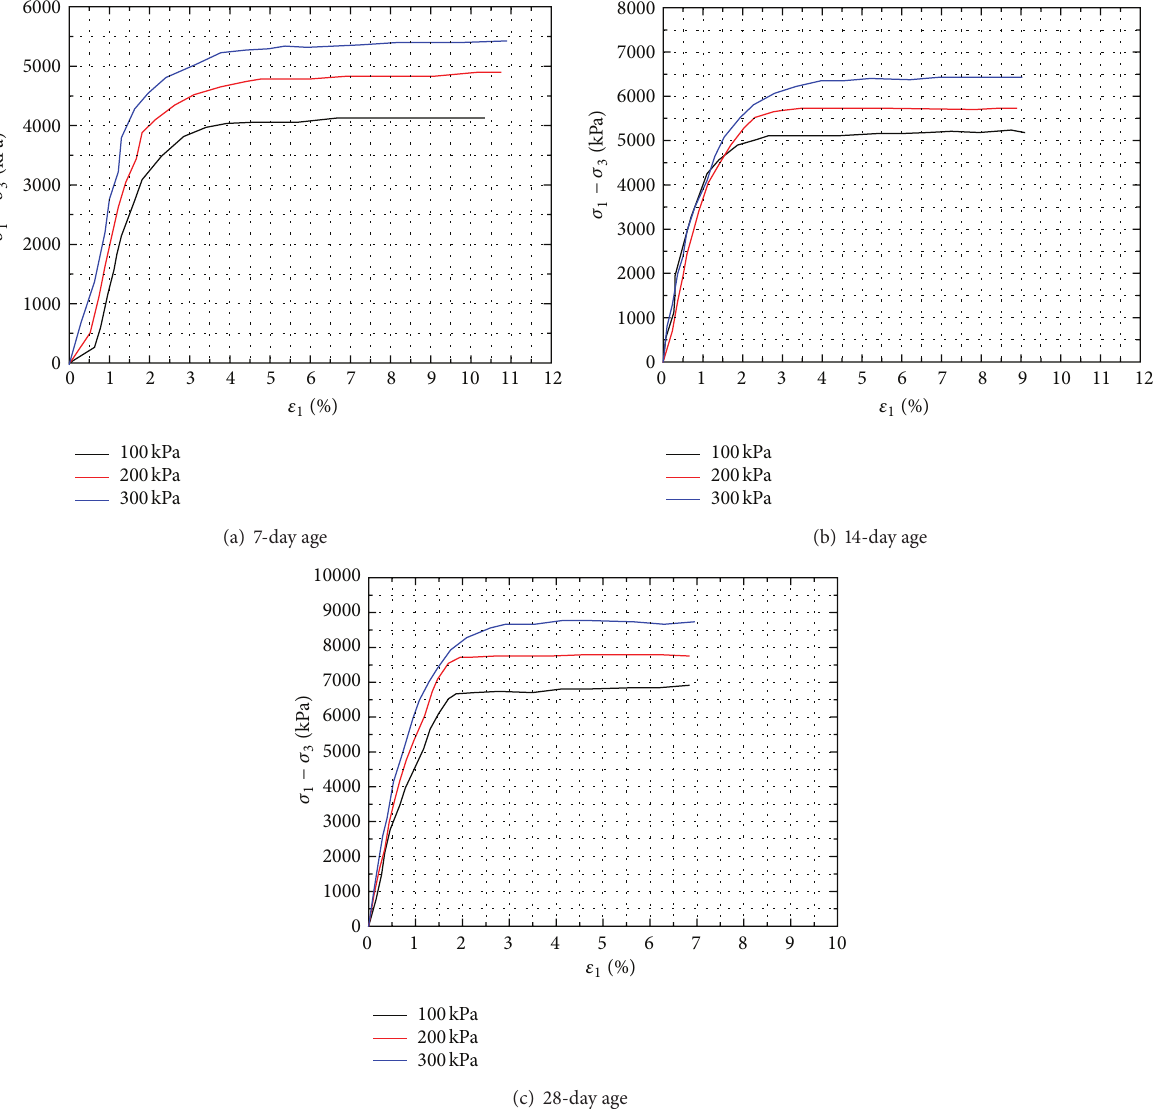
Figure 3: Stress-strain curve of adding 0.5% polypropylene